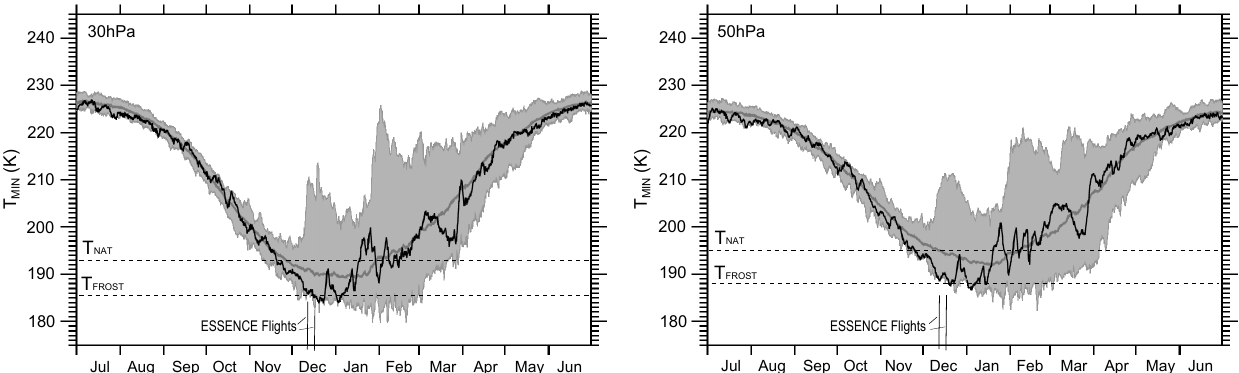
Figure 2. Climatology of temperatures between 65 and 90 ◦ N (gray curve) and range of minimum temperatures (shaded area) in the region of Fig. 1 at 30hPa (left panel) and 50hPa (right panel) for the years between 1989 and 2009. The black curve displays the minimum temperature for the winter 2011/2012, when two flights with were conducted the M-55. The plot is analogous to the figure provided for the winter 2009/2010 in Dörnbrack et al. (2012), with the same data source (ECMWF reanalysis at 6-hourly temporal resolutions) and PSC formation temperatures T NAT and T ICE calculated for 5ppmv of water vapor and 10ppbv of nitric acid trihydrate (NAT).